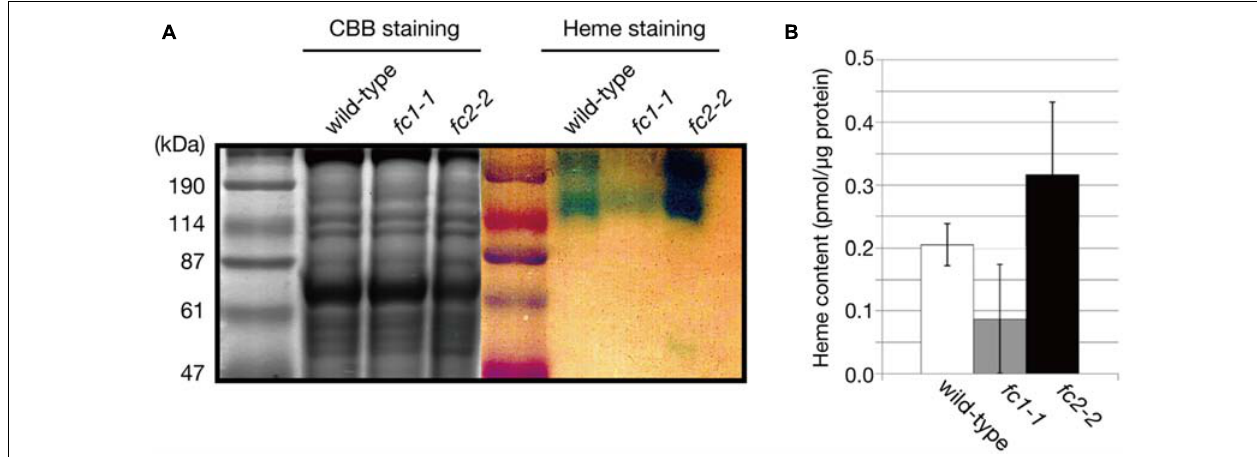
FIGURE 7 | Heme staining of ER-enriched microsomal light membrane (LM) fraction. (A) CBB and heme staining of the LM fraction (30 µ g/well) of wild type, fc1-1 , and fc2-2 . Blue staining represents the heme-dependent peroxidase activity. (B) Heme levels in LM fractions were determined by highly sensitive heme assay. Bars indicate SEM from three independent